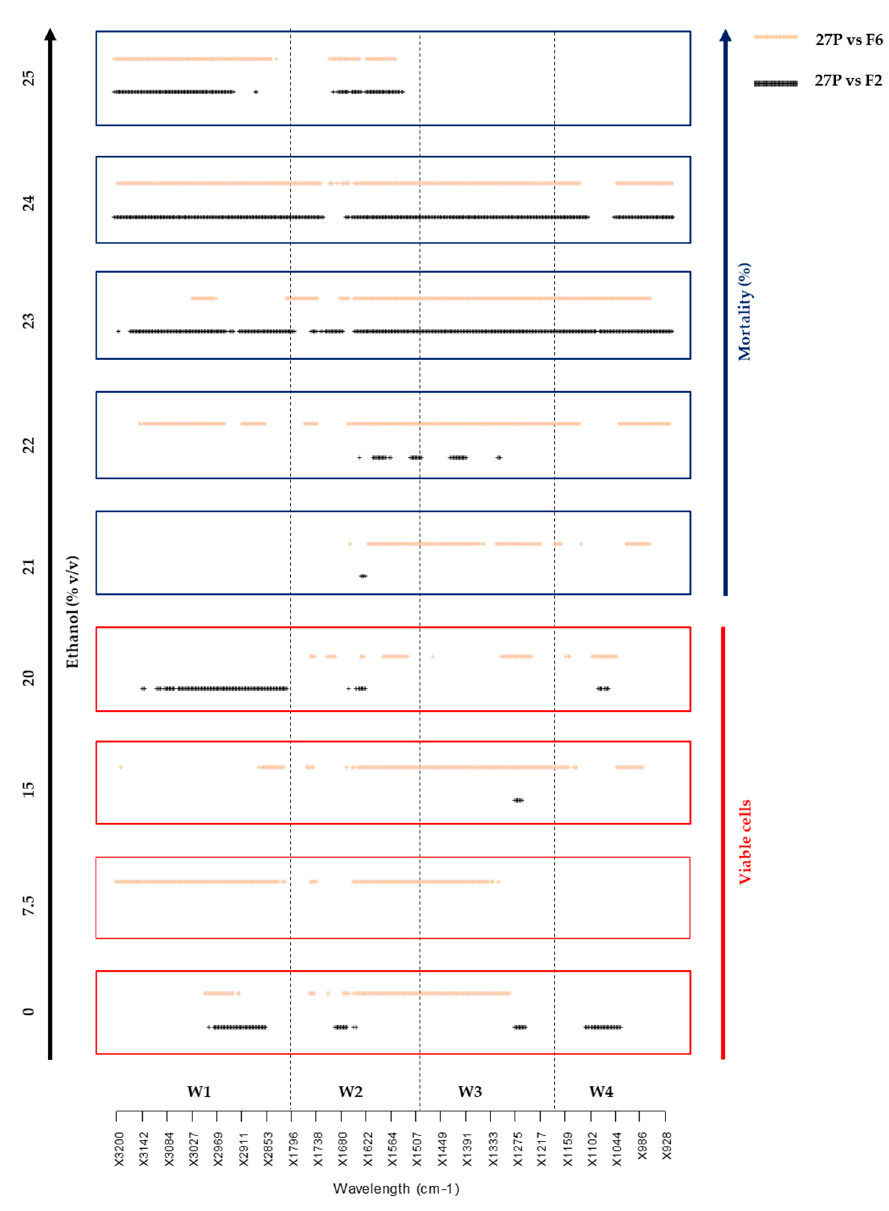
Figure 1. FTIR fingerprints of the parental S. cerevisiae 27P vs . recombinant strains (F2 and F6) at increasing ethanol concentrations (0%, 7.5%, 15%, 20%, 21%, 22%, 23%, 24%, 25 % v / v). Legend. Specific spectral areas involved in the ethanol response were considered, namely: fatty acids (W1), amides (W2), mixed region (W3) and carbohydrates